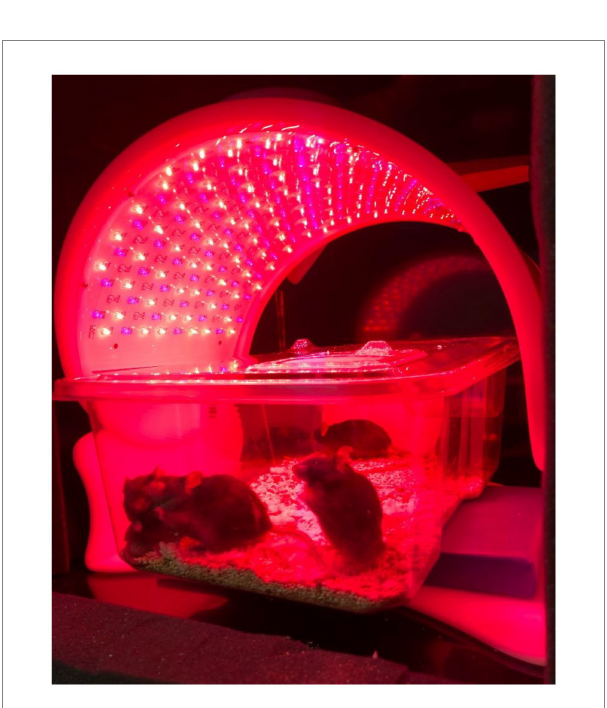
FIGURE 2 Apparatus setup. Auragen light therapy units contain a matrix of LEDs, which consists of an array of three different types of LED bulbs that can emit light either at 640 nm (red), 880 nm (NIR), and 465 nm (blue turquoise),